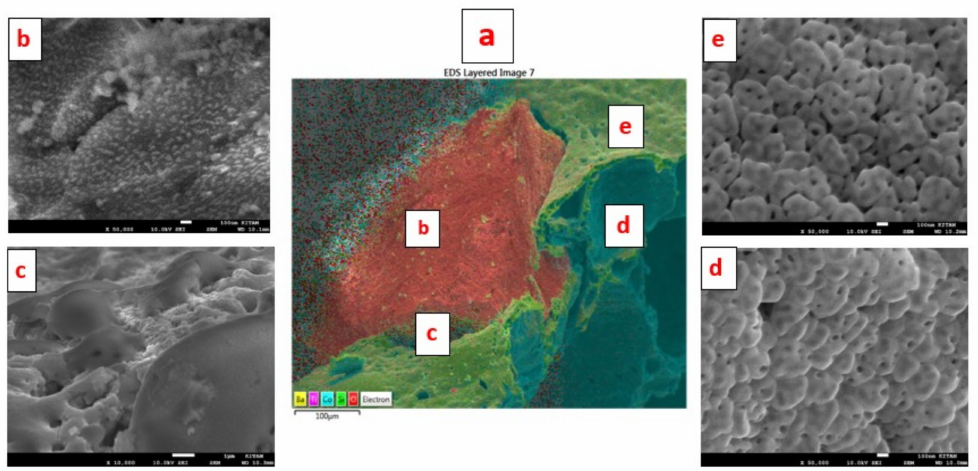
Figure 31. Morphology of {Co / Si = 2} / BT = 1 / 4 composite catalyst as a function of composition at various locations. ( a ) EDS image of the composite catalyst with a large (ca. 500 µ m) BaTiO 3 particle coated with porous Co / Si = 2 supported catalyst, (scale bar = 100 µ m). ( b ) SEM image of the location ( b ) showing BaTiO 3 rich particle surface with some Co / Si = 2 deposition (scale bar = 100 nm). ( c ) SEM image of the location ( c ) showing partially covered BaTiO 3 particle (scale bar = 1 µ m). ( d ) SEM image of the location ( d ) with very high concentration of reduced cobalt (scale bar = 100 nm). ( e ) SEM image of location ( e ) above the pore where a very high level of reduced cobalt is present (scale bar = 100 nm). See Table 10 for the elemental composition at each location.